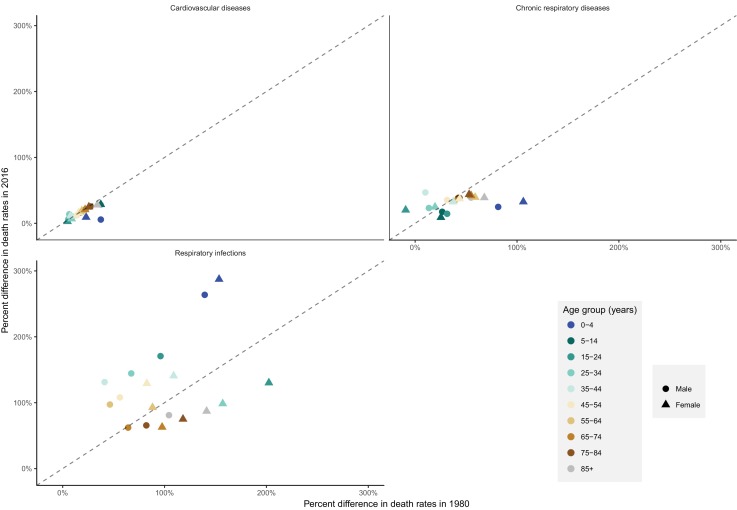
National percent difference in death rates between the maximum and minimum mortality months for specific cardiorespiratory diseases in 2016 versus 1980, by sex and age group.